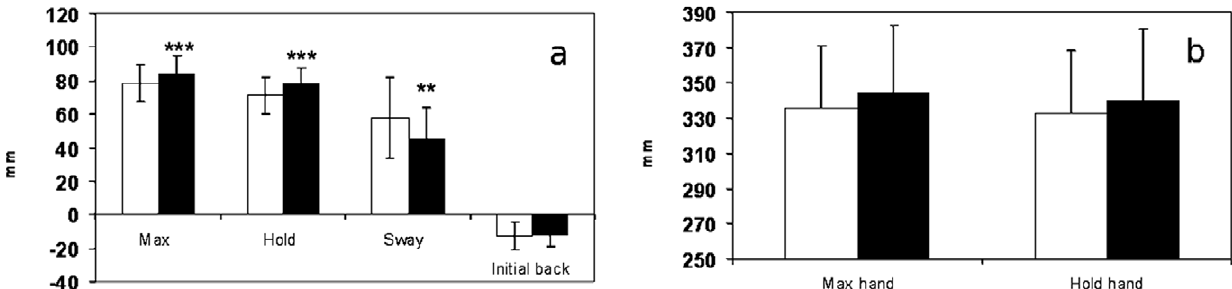
Figure 3. Mean forward displacement of the COP and dominant hand on level ground. (a) Mean forward movement of the COP on a level ground in no touch (white) and touch (black) conditions for variables: Max - forward displacement of the CoP, Hold – average position of the COP in the end position that lasted 2 seconds; Sway - of the COP during a 2 second hold of the reach expressed as path length, Initial back - initial backward displacement of the COP during reach).(b) Mean movement of the hand during the reaching movement in the no touch (white) and touch (black) conditions. The significant differences are marked as **p , 0.01; ***p , 0.001.